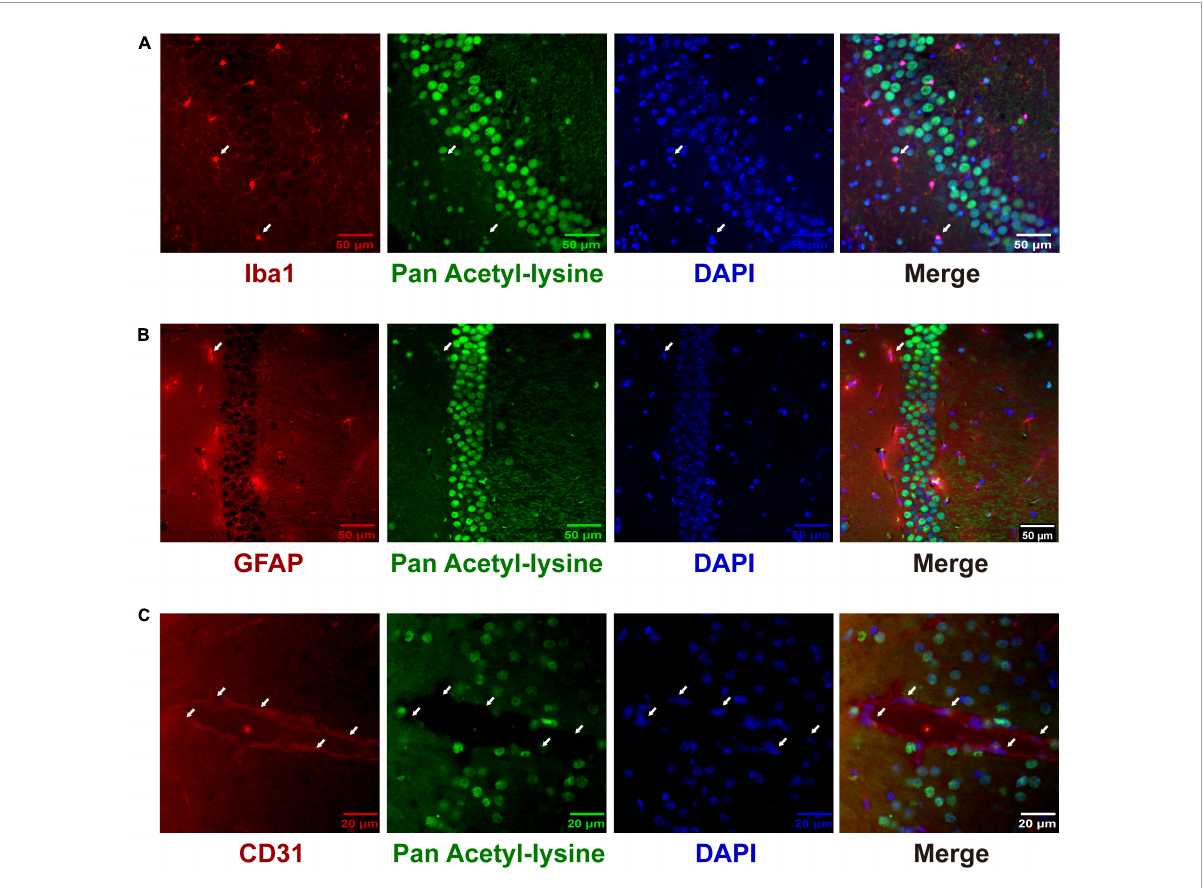
FIGURE9 The distribution of acetylated proteins in microglia (A) , astrocytes (B) , and cerebrovascular endothelial cells (C) . The co-localization of acetylated proteins (Green) with microglia, astrocytes, and cerebrovascular endothelial cells (Red) was analyzed by immunofluorescence in coronary sections of the mouse brain. Representative hippocampus images of Iba1 (A) and GFAP (B) staining ( n = 3); scale bar = 50 µ m. Representative cortex image of CD31 (C) staining ( n = 3); scale bar = 20 µ m. The white arrows indicated the positively stained nuclei of Iba1- and GFAP-positive cells and the negatively stained nuclei of CD 31-positive cells. Scale bar = 50 or 20 µ